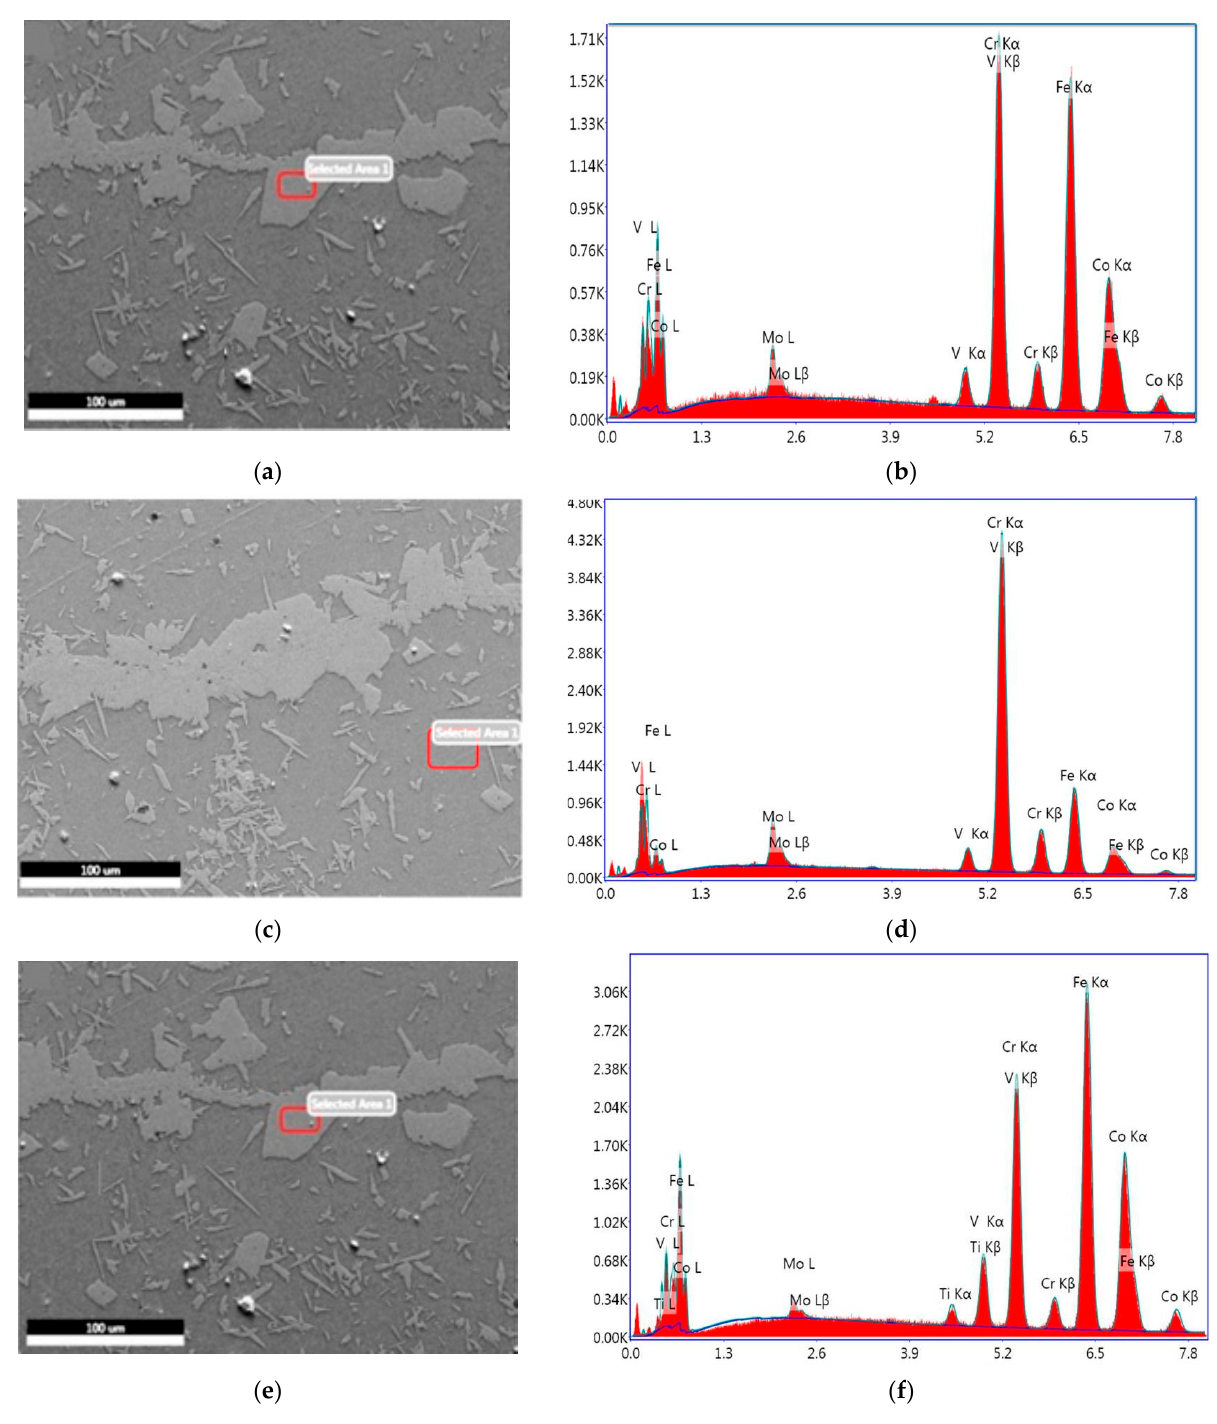
Figure 6. Energy dispersive X-ray analysis of selected area images and their cross ponding elemental composition spectra of ( a ) Sample A; ( b ) Spectrum A; ( c ) Sample B; ( d ) Spectrum B; ( e ) Sample C; and ( f ) Spectrum C.